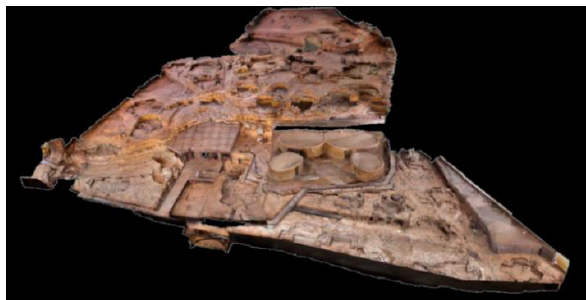
Figure 11. 3D model of the Cave Painted archaeological park with photorealistic quality.